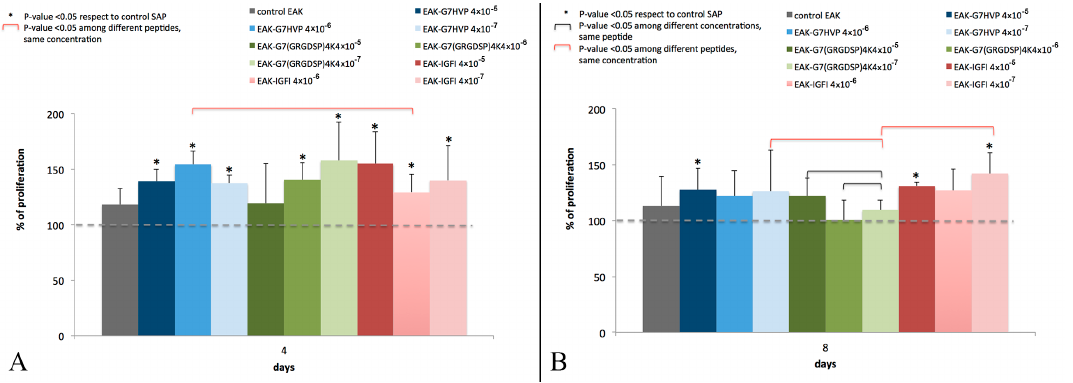
Figure 8. Percentage of cellular proliferation after four days ( A ); and eight days ( B ), as indication of Mesenchymal Stem Cell (MSC) adhesion, normalized to the Self-Assembling Peptide (SAP) control.